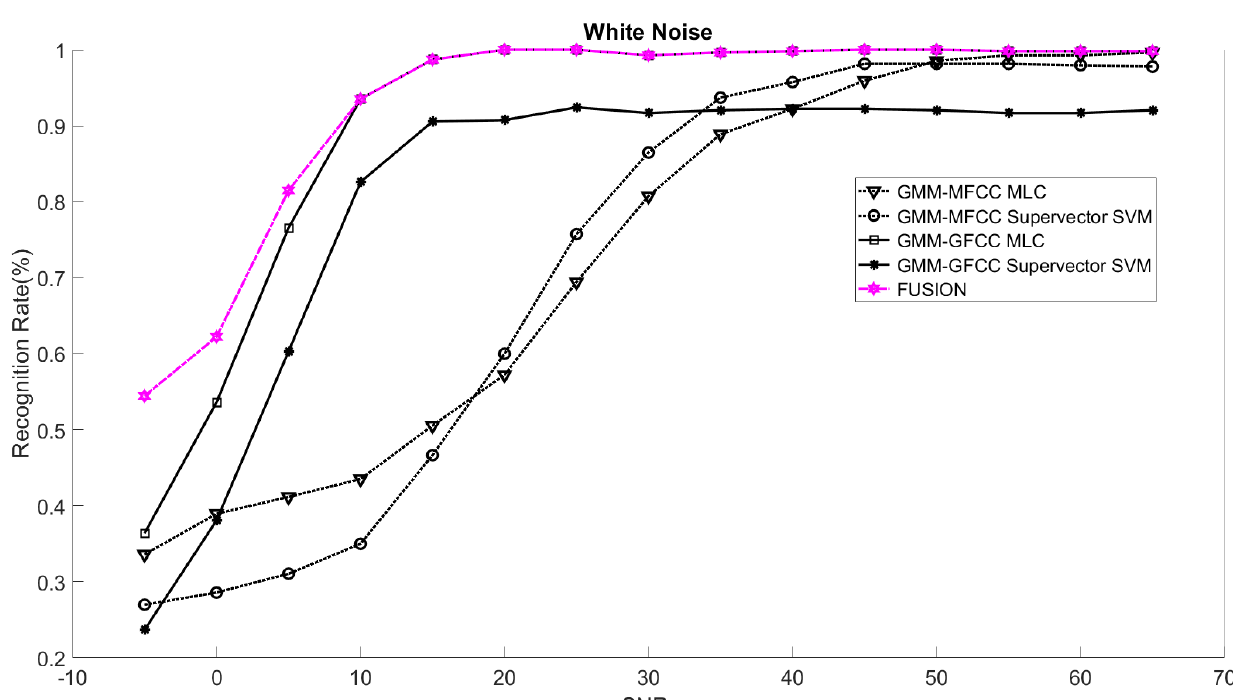
Figure 19. Rank-1 recognition rates of the fusion system and the base classifiers (two-stage) on utterances distorted with white noise.